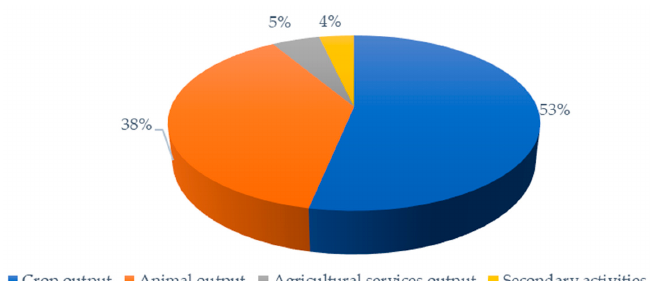
Figure 5. Total agricultural output structure at the level of the EU, 2020. Source: Authors’ calculation and representation, according to Eurostat (2020) data.